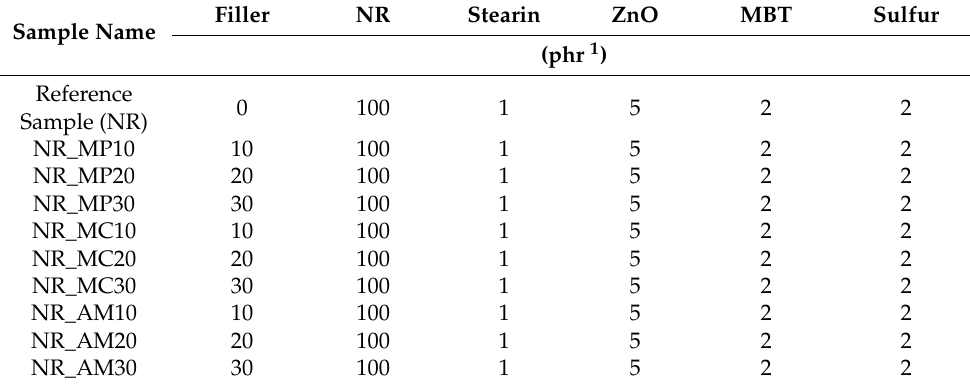
Table 7. The composition of elastomeric